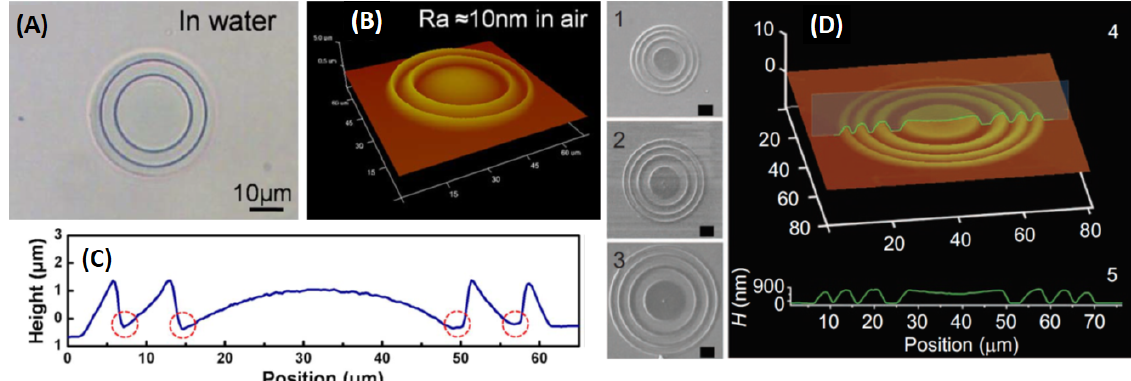
Figure 8. ( A ): Optical microscopy picture of a protein harmonic diffractive microlens in water; ( B ): atomic force microscopy (AFM) image of the microlens in (A). Roughness average is ∼ 10 nm; ( C ): section contour of the microlens in (A) characterized by AFM imaging in air. ( D ): SEM images of protein micro-KPLs on a glass coverslip with 1 µ m thickness but different diameters, (1) 50 µ m, (2) 60 µ m, and (3) 80 µ m. Scale bar 10 µ m. (4) AFM characterization exhibiting the 3D morphology and the 10 nm average roughness of the protein micro-KPL (diameter 60 µ m). (5) The thickness of the protein micro-KPL at the central line in (4) as measured by AFM. Panels A-C, adapted and reprinted with permission from [116]. Panel D adapted and reprinted with permission from [52].